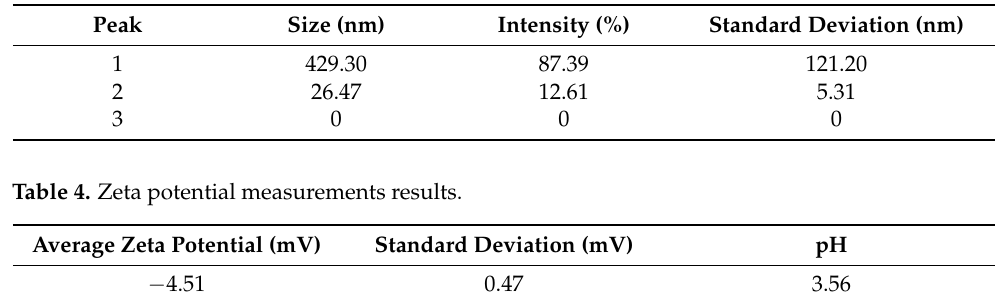
Figure 3. Particle size distribution from the DLS measurements and zeta potential distribution.